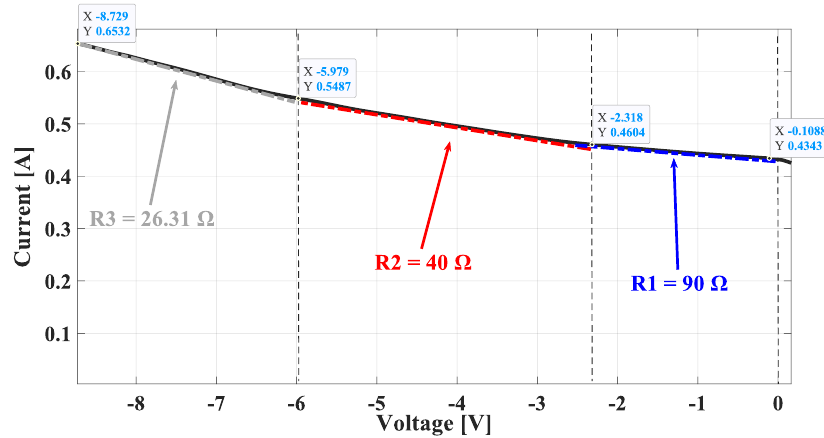
Figure 6. Estimation of DRM parameters for Q 2 .